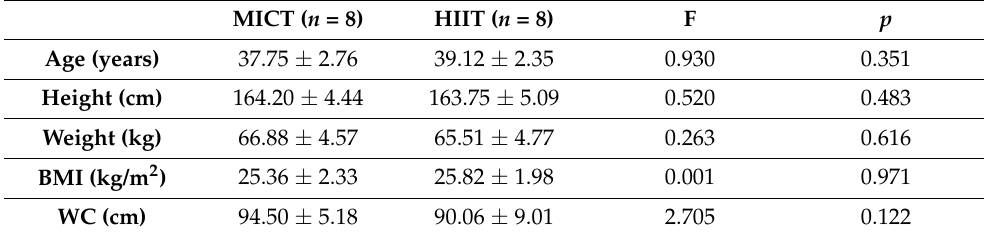
Table 1. Subject